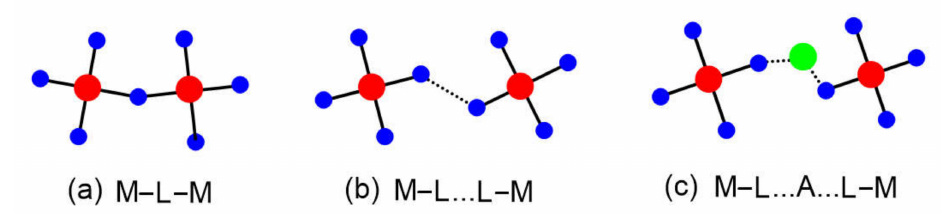
Figure 2. Three types of spin exchange paths associated with two magnetic ions: ( a ) M–L–M, ( b ) M–L . . . L–M, and ( c ) M–L . . . A . . . L–M, where A represents a d 0 cation such as V 5+ or W 6+ . The M, L, and A are represented by red, blue, and green circles,